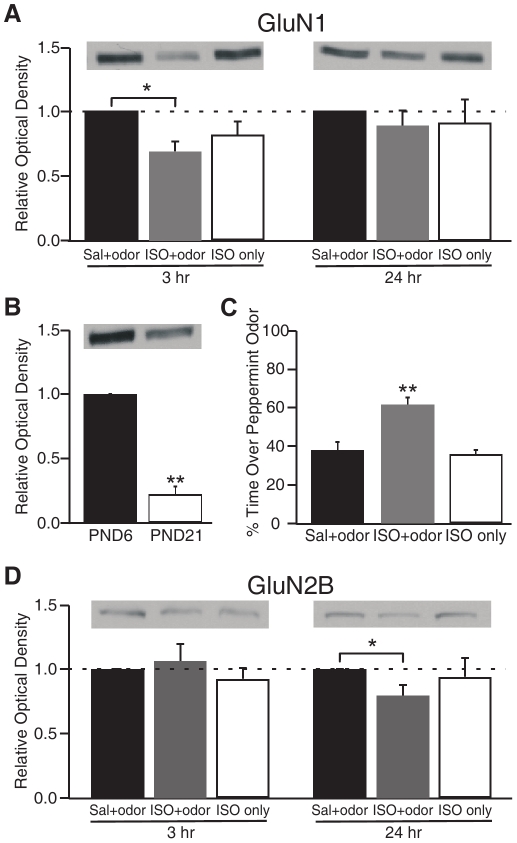
Early odor preference learning significantly down-regulated synaptic NMDAR subunits expression in the olfactory bulb.
A
. Western blot analysis of olfactory bulb synaptoneurosome samples collected at 3 h and 24 h following early odor preference training. Relative optical density values are normalized to the saline+odor group. B
. Western blot analysis of olfactory bulb synaptoneurosome samples collected from naïve PND 6 and 21 rats. C
. Two-choice odor test of the littermates. D. GluN2B expressions at 3 h and 24 h following early odor preference training. Relative optical density values are normalized to the saline+odor group. **p<0.01. *p<0.05. Error bars, mean±SEM.